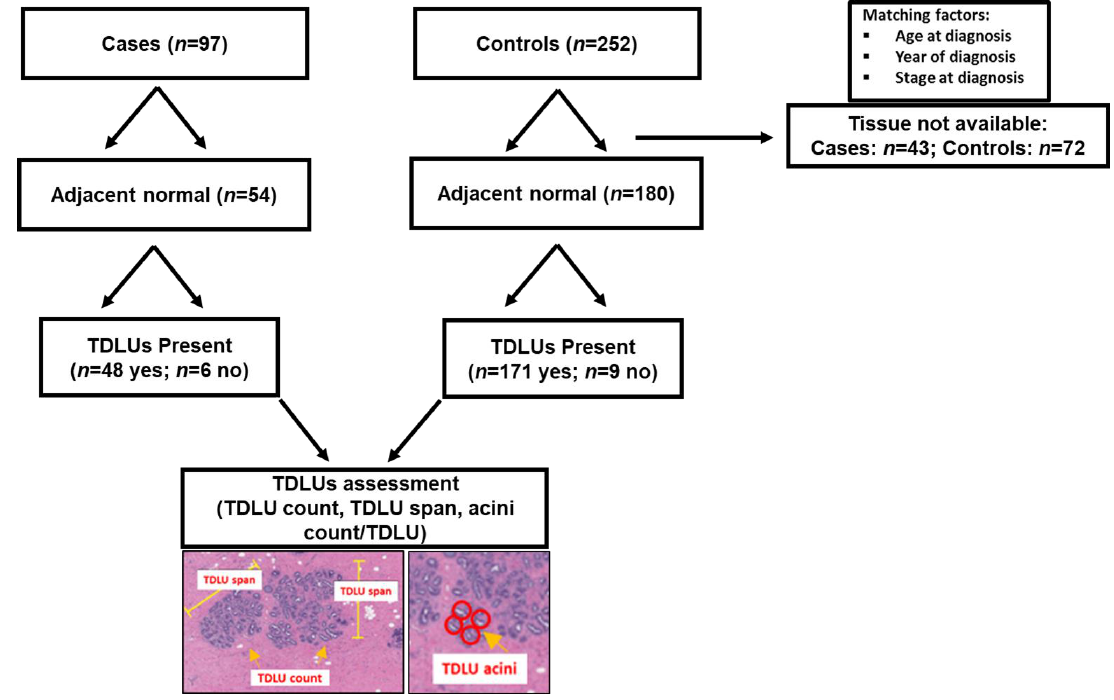
Figure 1. Overview of the study population of breast cancer cases and controls with benign breast tissue suitable for terminal duct lobular unit (TDLU) assessment in this study and representative examples of TDLU measures. TDLU